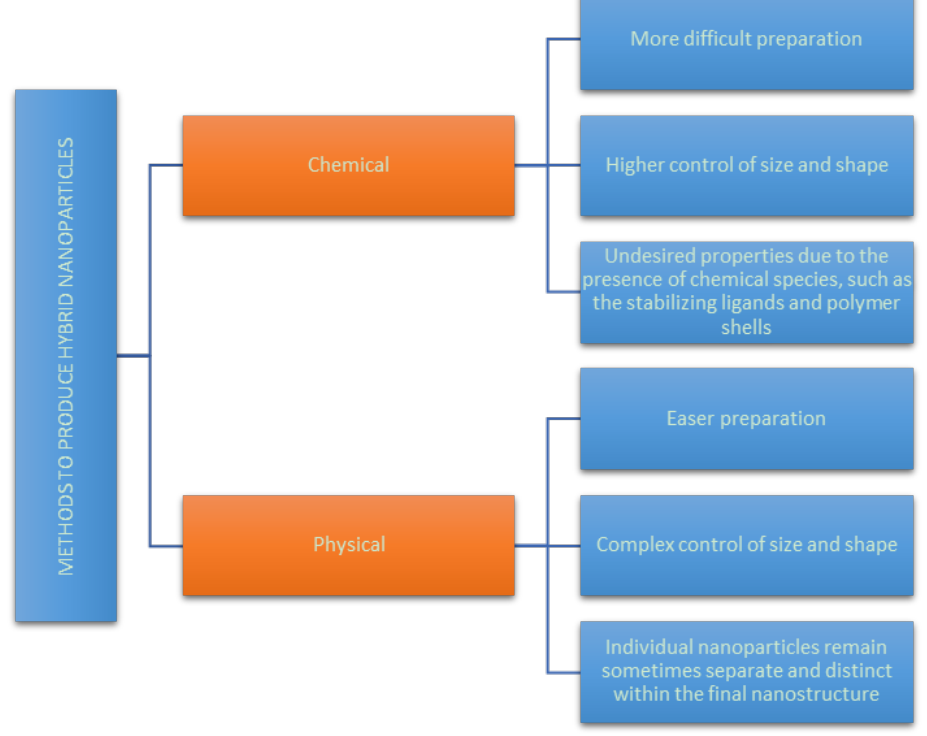
Figure 2. Advantages and disadvantages of the chemical and physical methods available to produce hybrid nanoparticles.